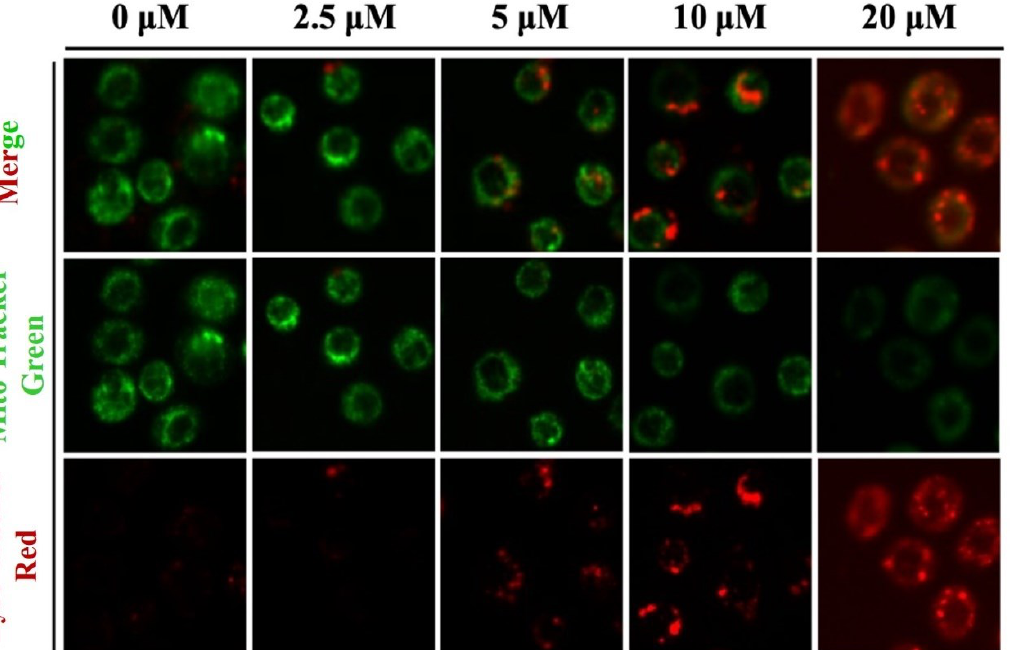
Figure 6. The effect of IVM on AMPK/mTOR signaling pathways in RAW264.7 cells. (A) Phosphor- ylated mTOR, AMPK, and p70s6k expression in RAW264.7 cells treated with IVM for 6 h. (B)